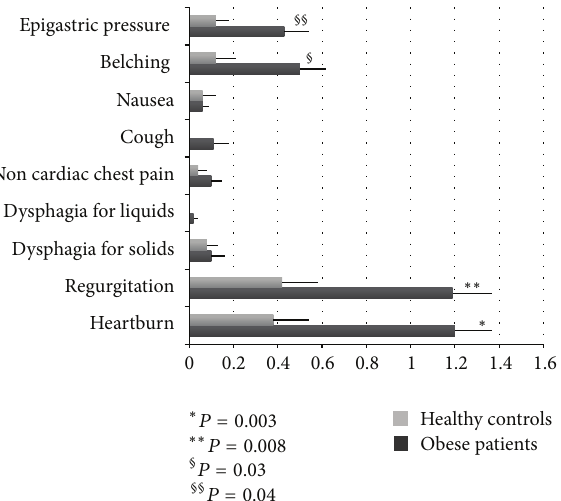
Figure 2: This figure shows the frequency-intensity scores (M ± SE) of GI symptoms: epigastric pressure, belching, nausea, cough, noncardiac chest pain, dysphagia for liquids, dysphagia for solids, regurgitation, and heartburn in obese patients and HC.